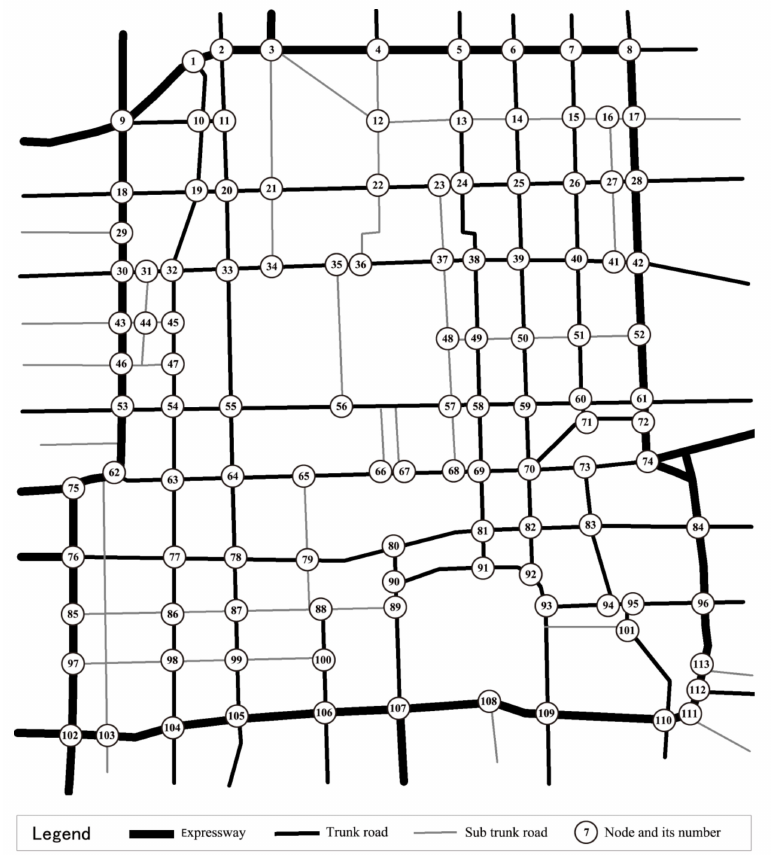
Figure 3. The road network topology map of Beijing Second